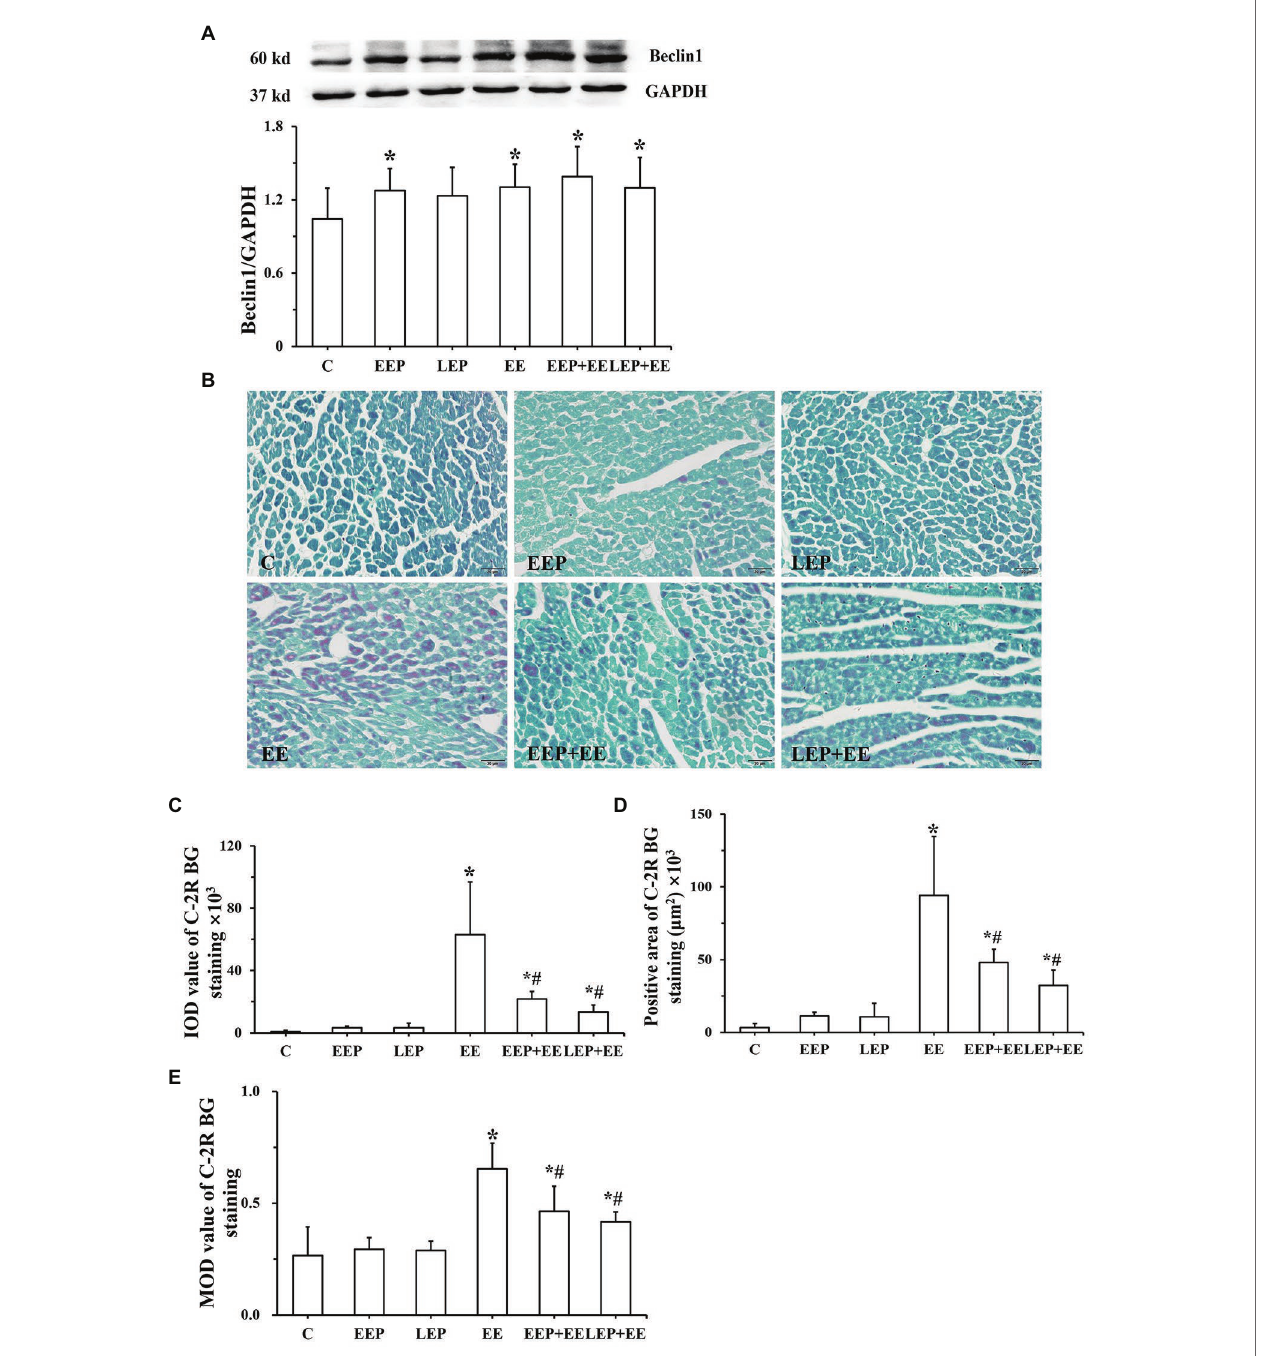
FIGURE 2 | Expression of Beclin1 and degree of ischemia-hypoxia in different groups. (A) Western blot analysis of Beclin1 in different groups. (B) Chromotrope-2R brilliant green (C-2R BG) ischemia-hypoxia staining (bar = 100 μ m). The C-2R BG-stained images showed that normal myocardium was stained green in contrast to the bright red of ischemic-hypoxic myocardium. (C) Integral optical density (IOD) of C-2R BG ischemia-hypoxia staining. (D) Positive area of C-2R BG ischemia-hypoxia staining. (E) Mean optical density (MOD) of C-2R BG ischemia-hypoxia staining. * p < 0.05 vs. group C and # p < 0.05 vs. group